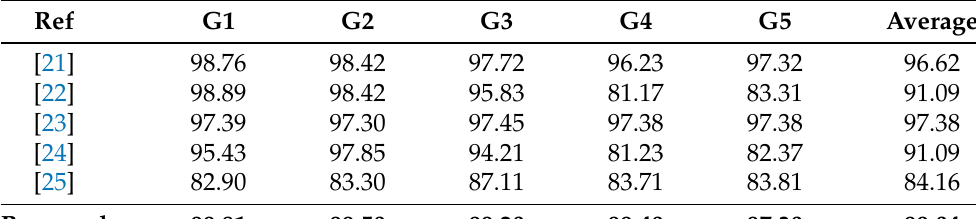
Table 4. License plate detection accuracy (%) comparison.